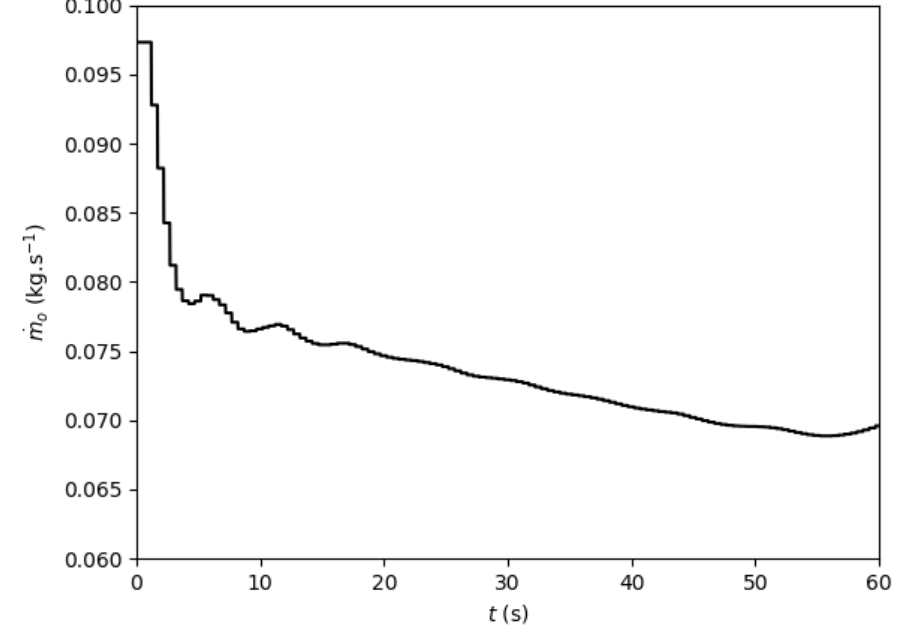
Figure A12. Oxidizer mass flow rate profile, feedback with downgraded regulation law, case